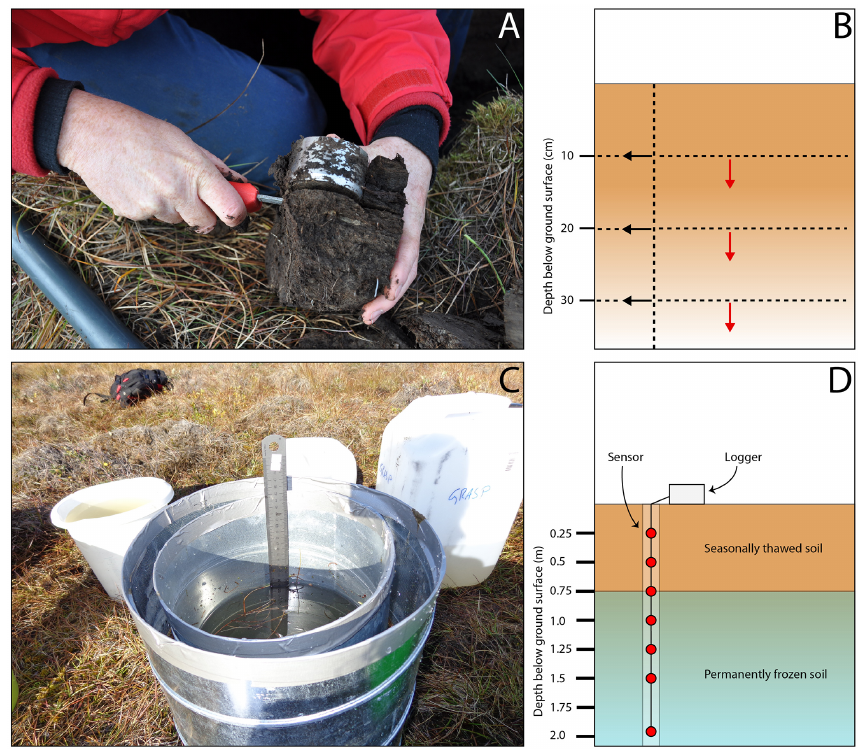
Figure 4. Photo of undisturbed soil samples (a) , a schematic figure of methods for taking undisturbed soil samples for analysis of vertical (red arrow) and horizontal (black arrow) hydraulic conductivity (b) , the infiltrometer used in the infiltration capacity measurements (c) , and a schematic figure of the soil temperature station (d)